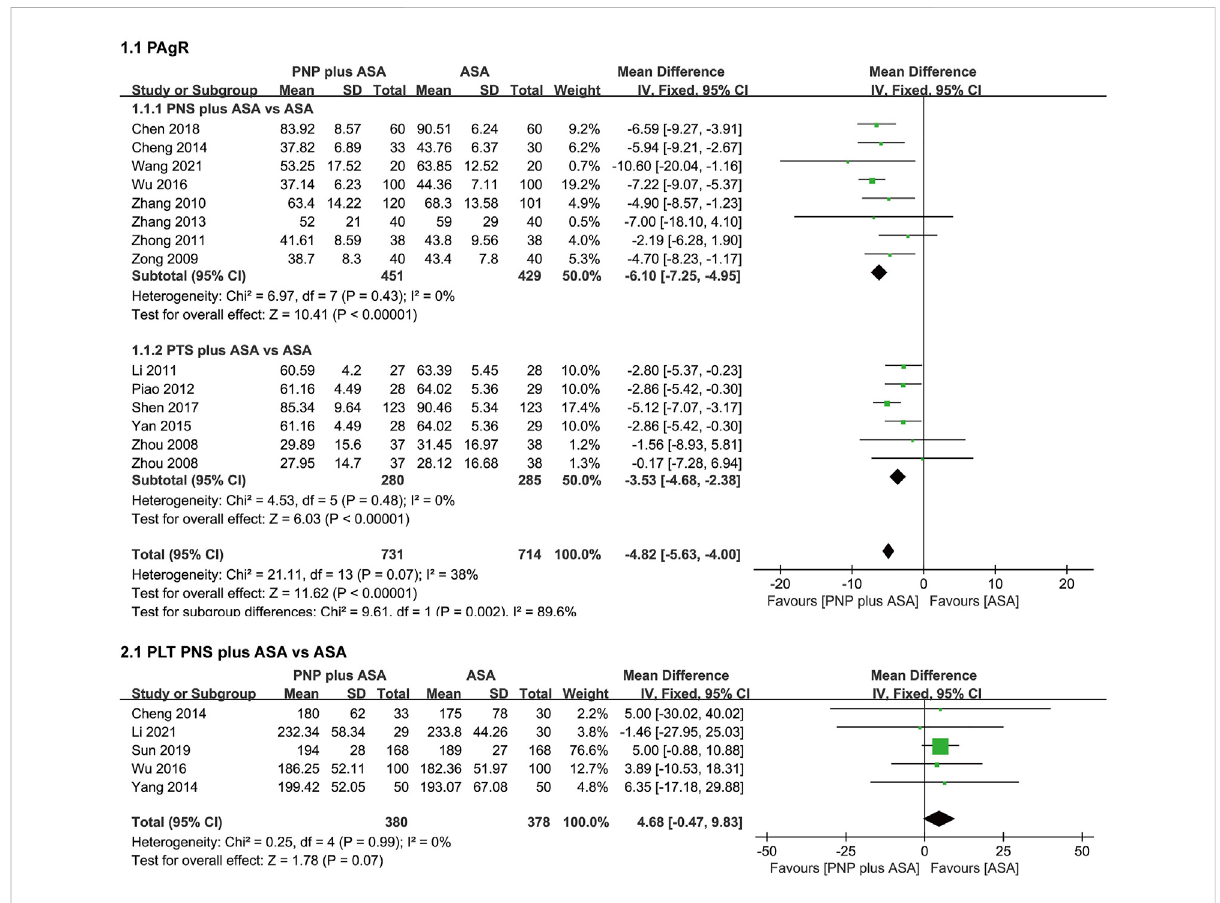
FIGURE 4 Forest plots of PAgR and PLT. PAgR, platelet aggregation rate; PLT, platelet